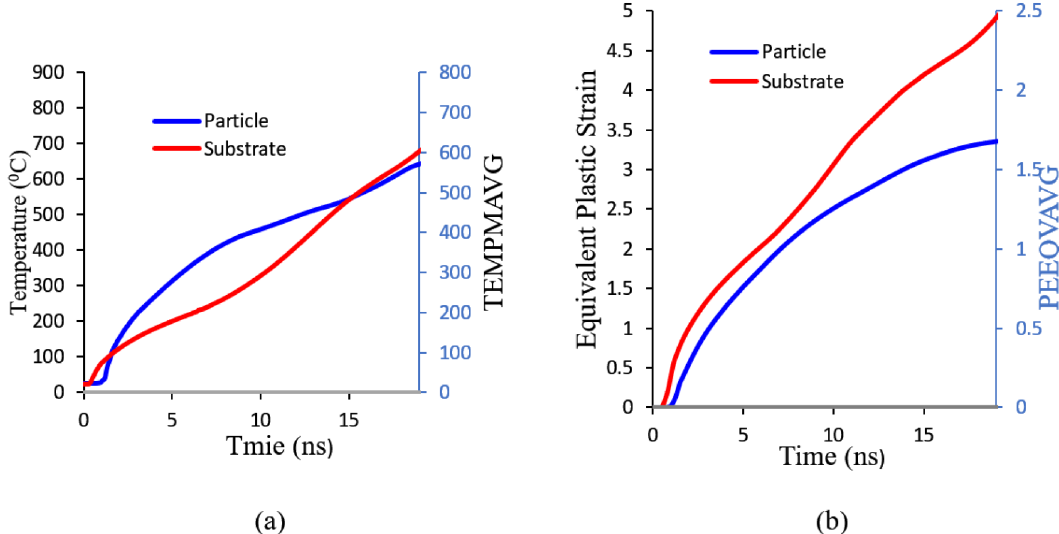
Fig. 12. The evolution of (a) temperature (b) plastic strain of Cu/Al impact at 500m/s impact velocity using the CEL numerical